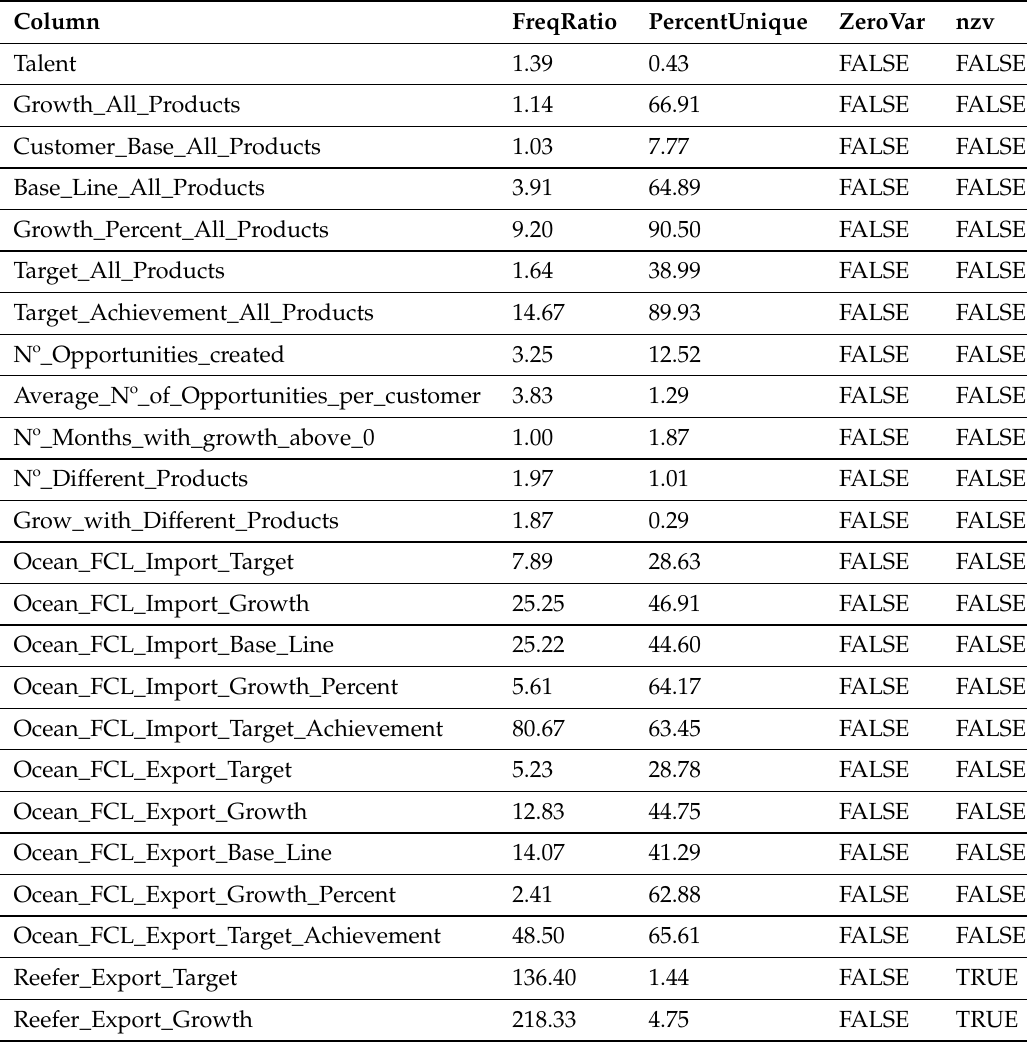
Table 4. Result of the nearZeroVar